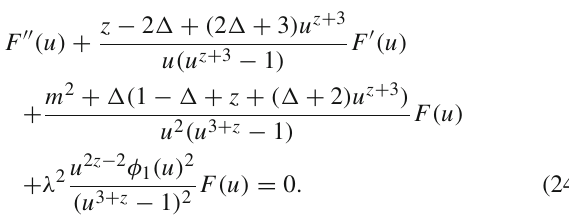
Fig. 4 The real part (solid) and imaginal part (dashed) of the AC conductivity at T γ = − 6 (black), γ = 0 (red), γ = 4 100 z = 5 (blue) in the right panel 2